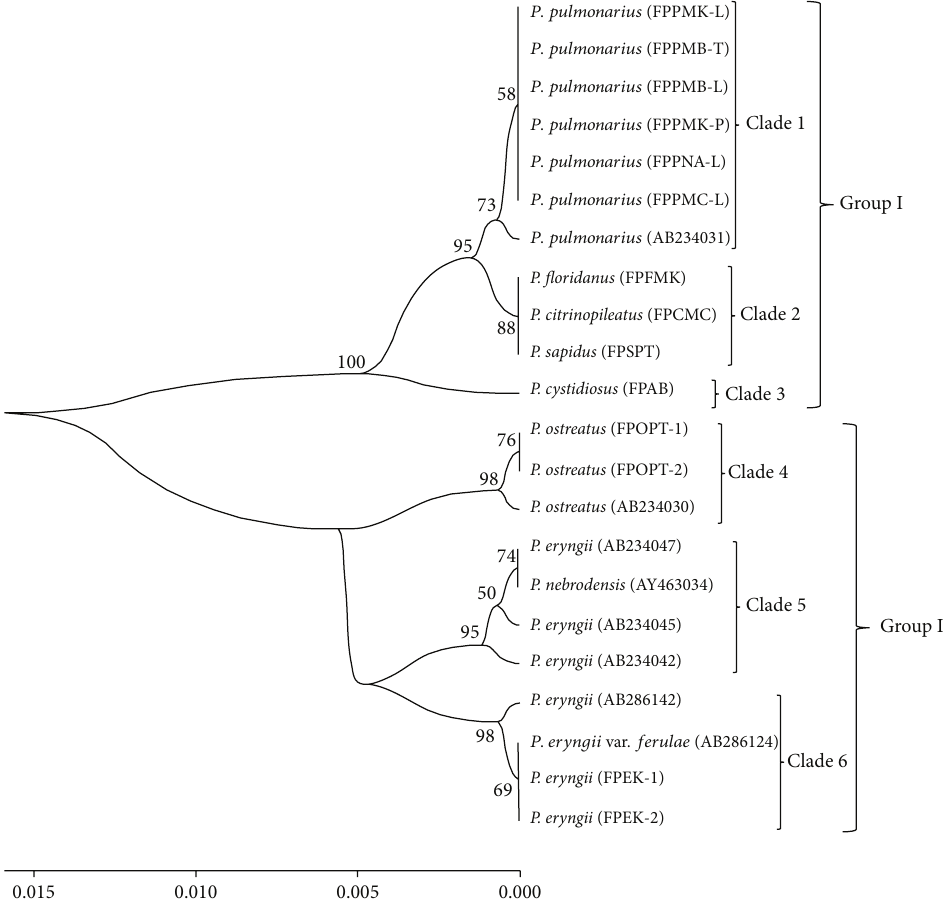
Figure 2: Phylogenetic tree constructed based on IGS1 sequences of experimental samples using UPGMA method. The sequences of AB234031( P.pulmonarius );AB234030( P.ostreatus );AB234045,AB234042,AB286142,andAB234047( P.eryngii );AY463034( P.nebrodensis ); and AB286124 ( P. eryngii var. ferulae ) were downloaded from NCBI GenBank. Numbers close to branches indicate 1000 replication of bootstrap test and the codes refer to sample